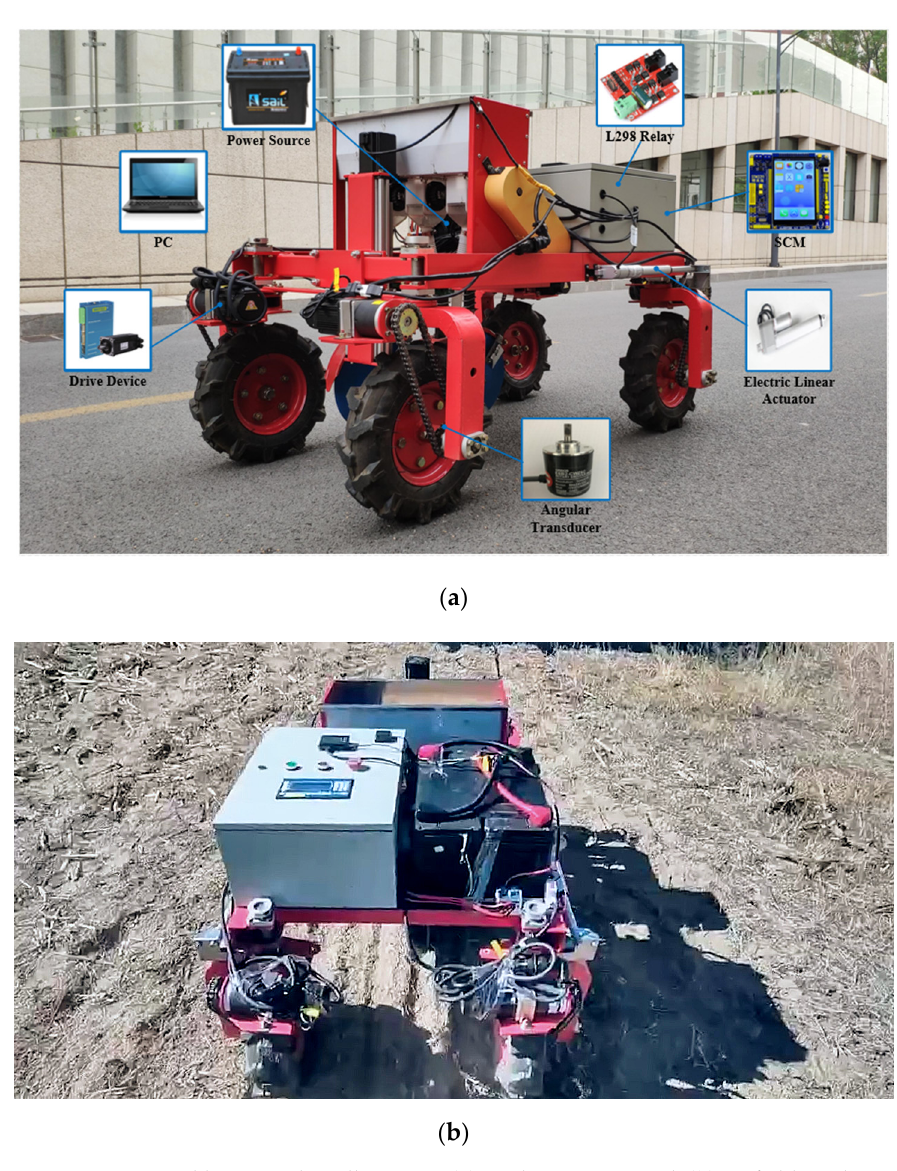
Figure 13. Practical linear path walking test: ( a ) on dry cement road; ( b ) on field road.